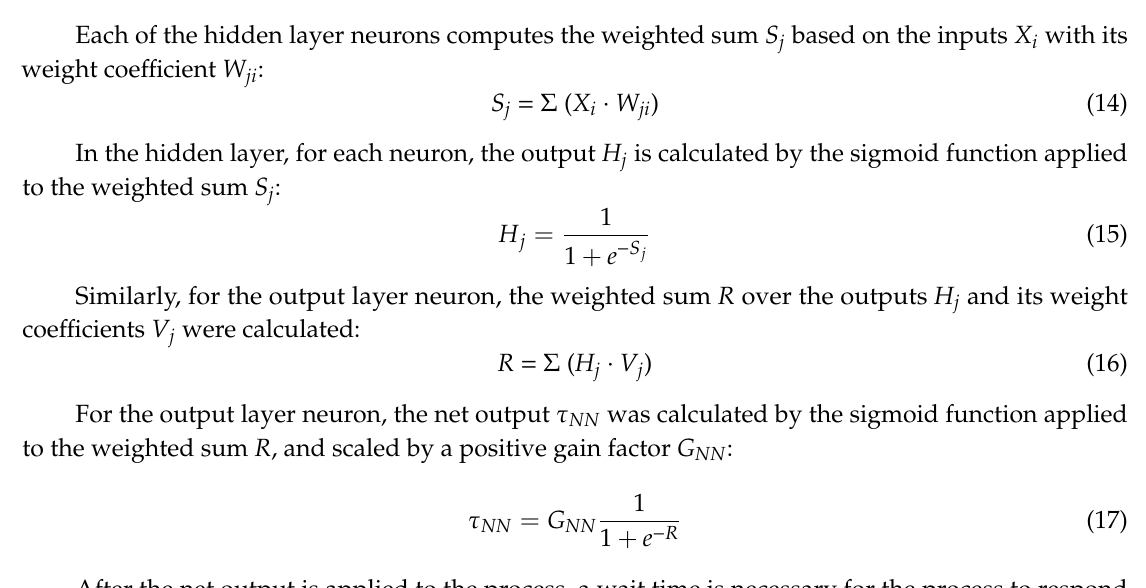
Figure 3. Recurrent neural network with three perceptron-layers.